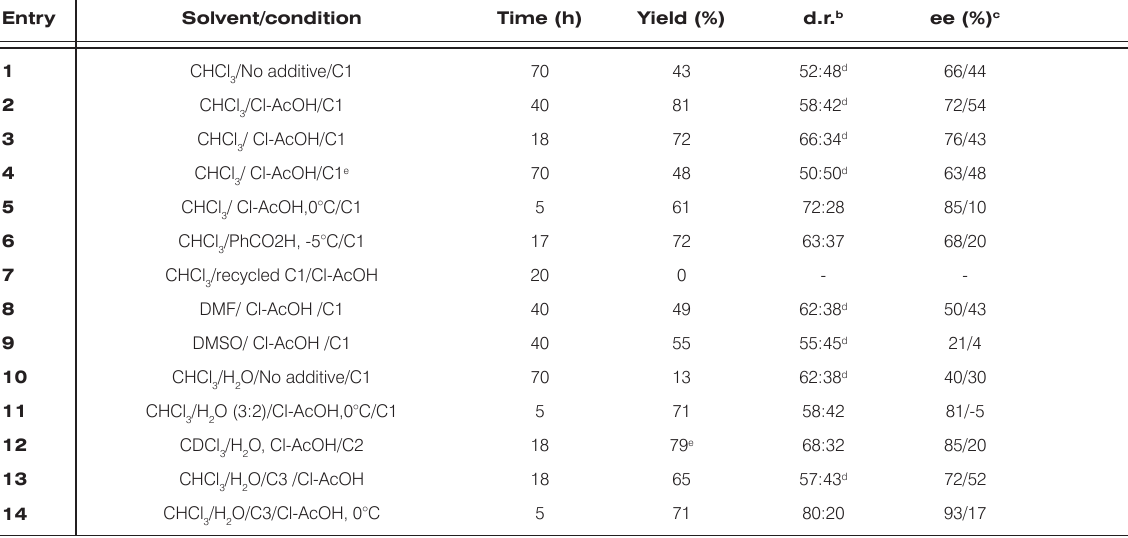
Table 1. Screening for optimal reaction condition on the addition of 5 to 6. a